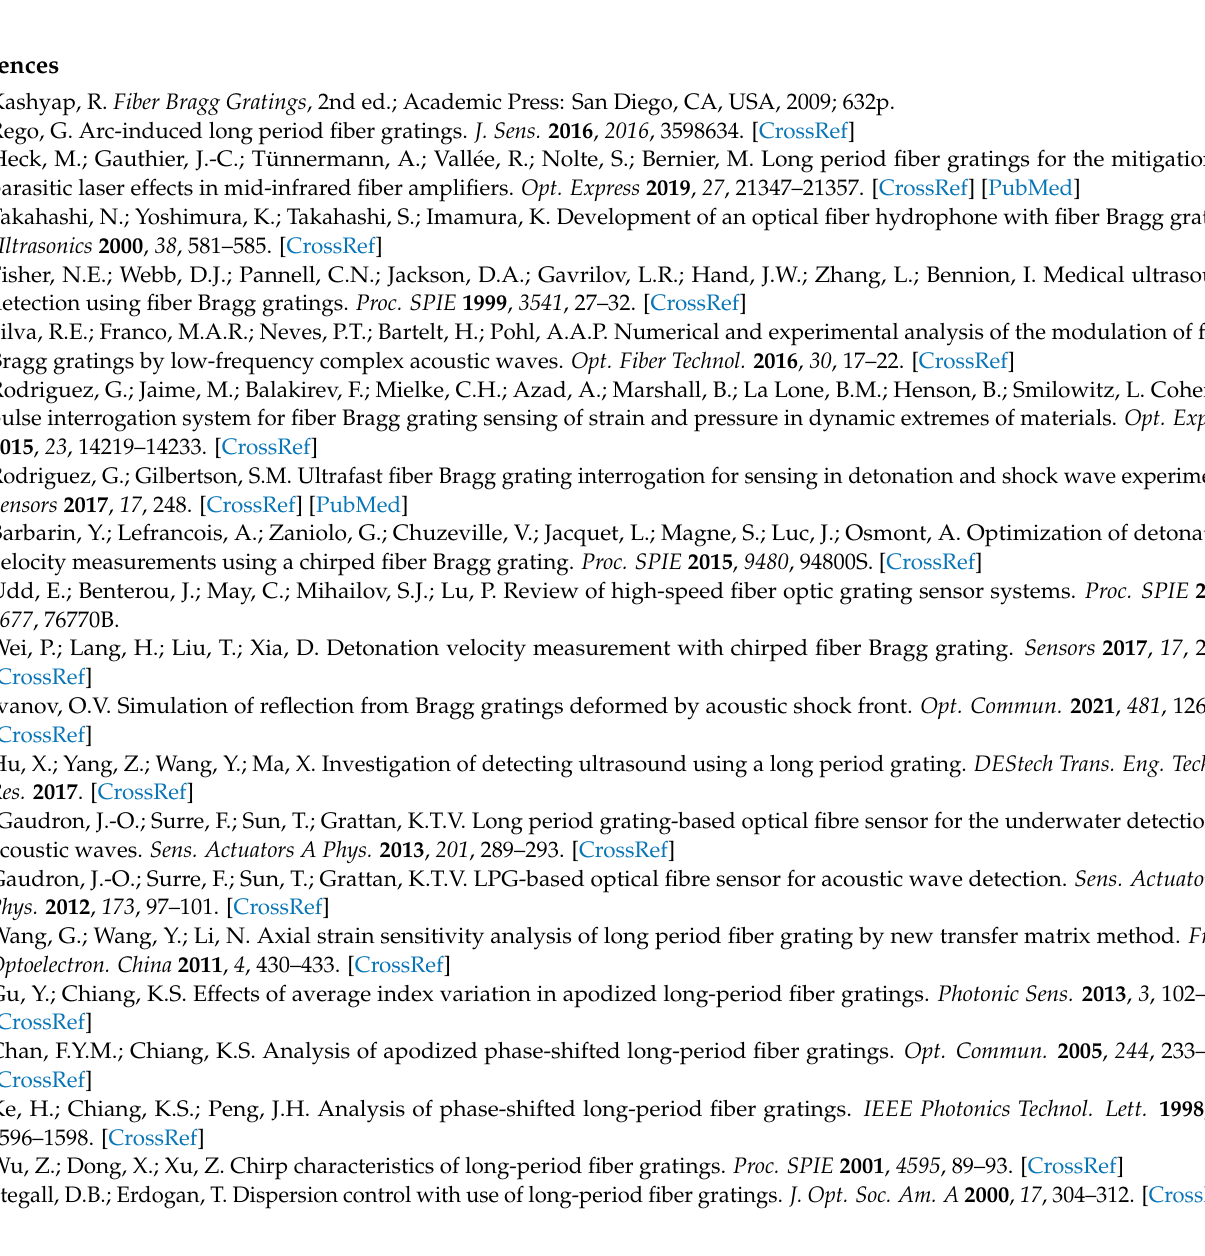
Figure A1. Electric field distributions of five fiber modes. The gray rectangle is the integration area for calculating the overlap